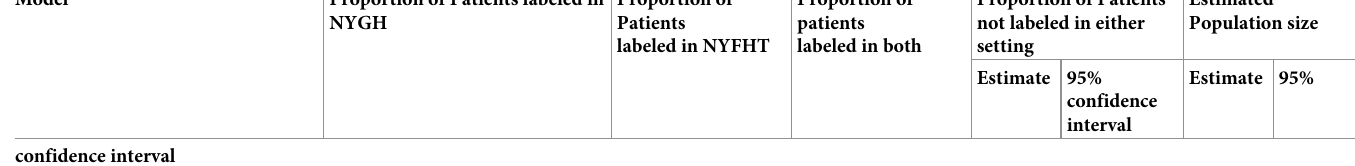
Table 4. Results of capture-recapture modelling to estimate population size of patients with schizophrenia and bipolar condition in NYGH and NYFHT.